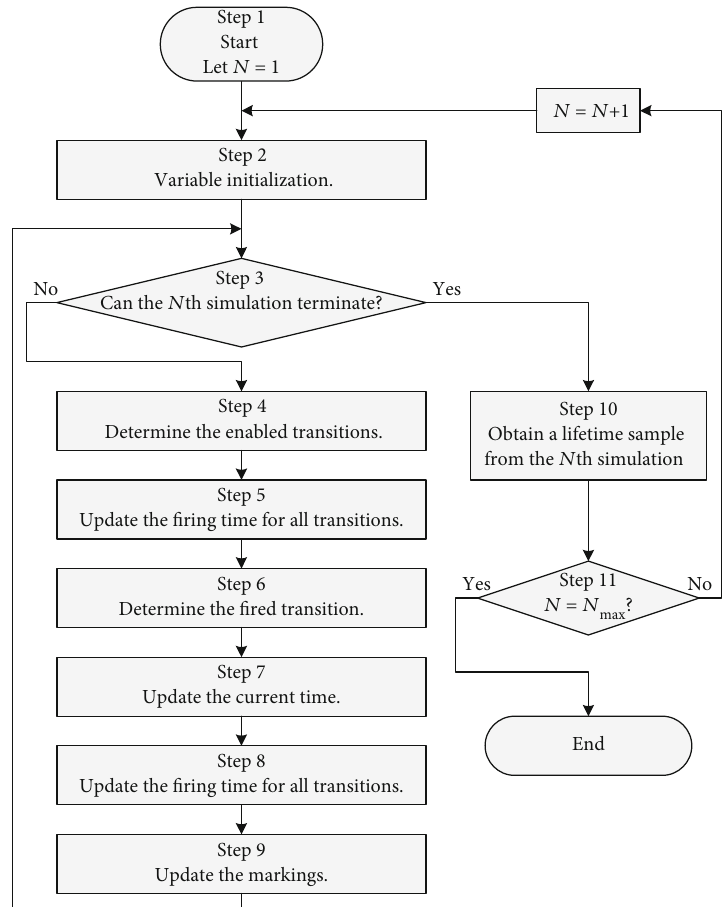
Figure 7: The Monte Carlo simulation procedure of the stochastic Petri net.